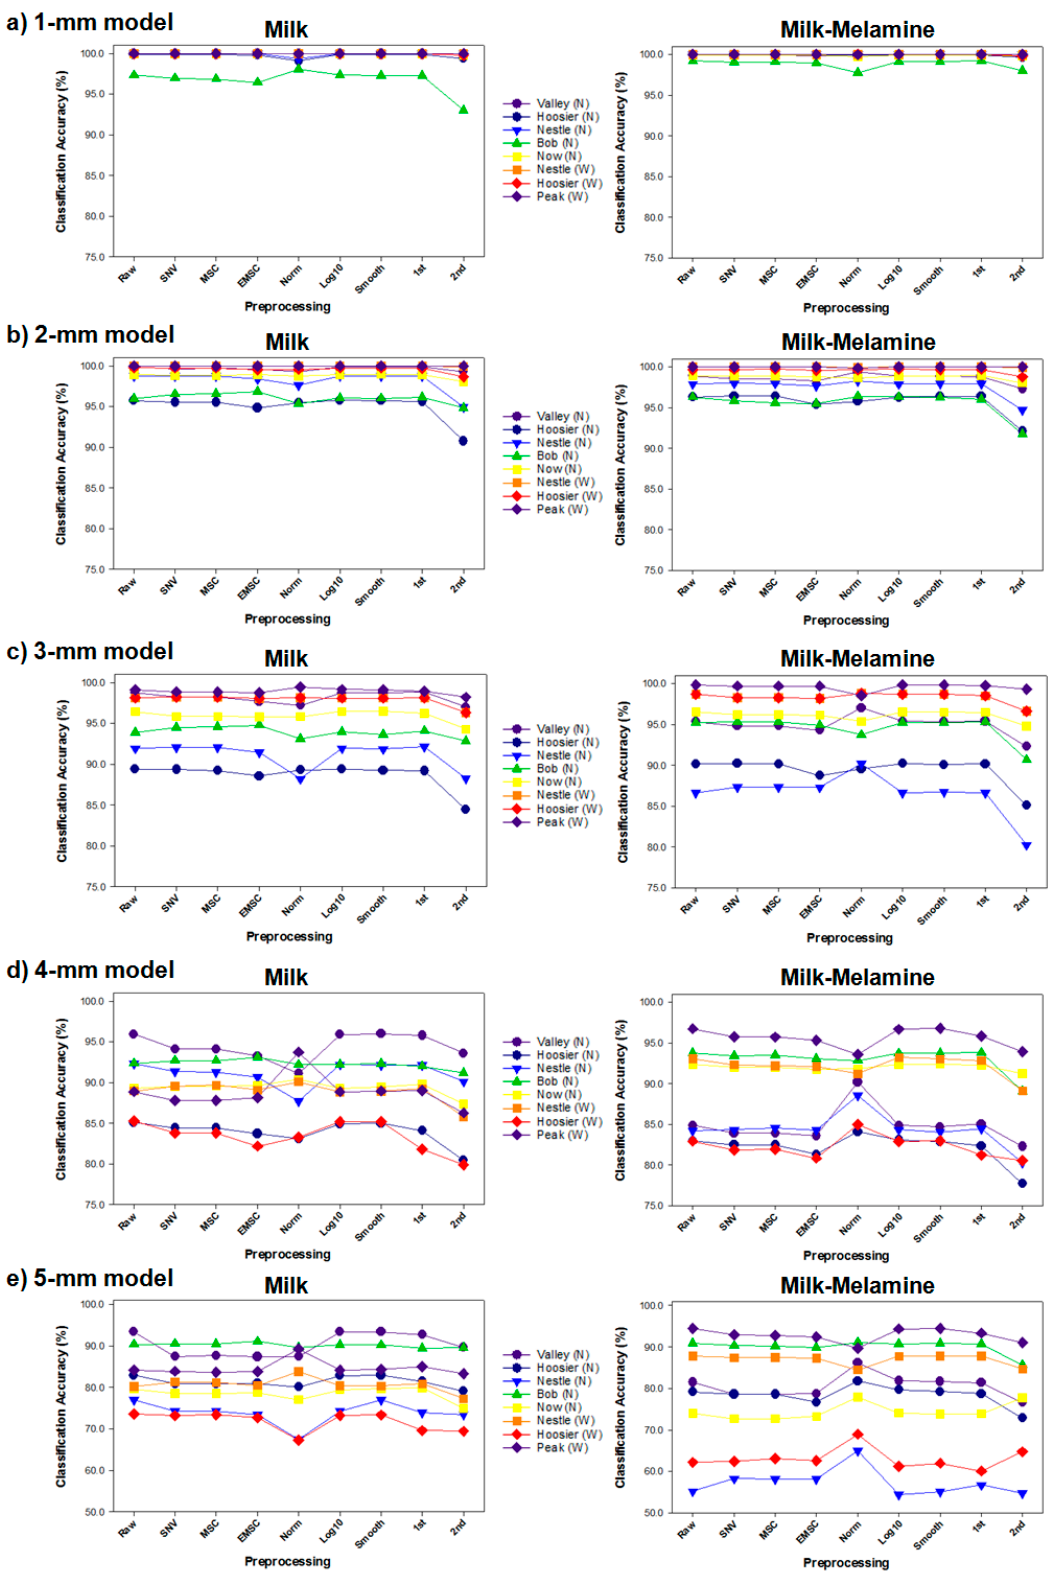
Figure 5. Classification comparison of classification results for PLS-DA models coupled with specific spectral preprocessing algorithms for milk-melamine samples at milk depths from 1 mm to 5 mm ( a – e ).